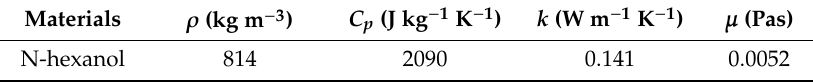
Table 5. Thermo-physical properties of n-hexanol (10 ◦ C, 0.1 MPa)